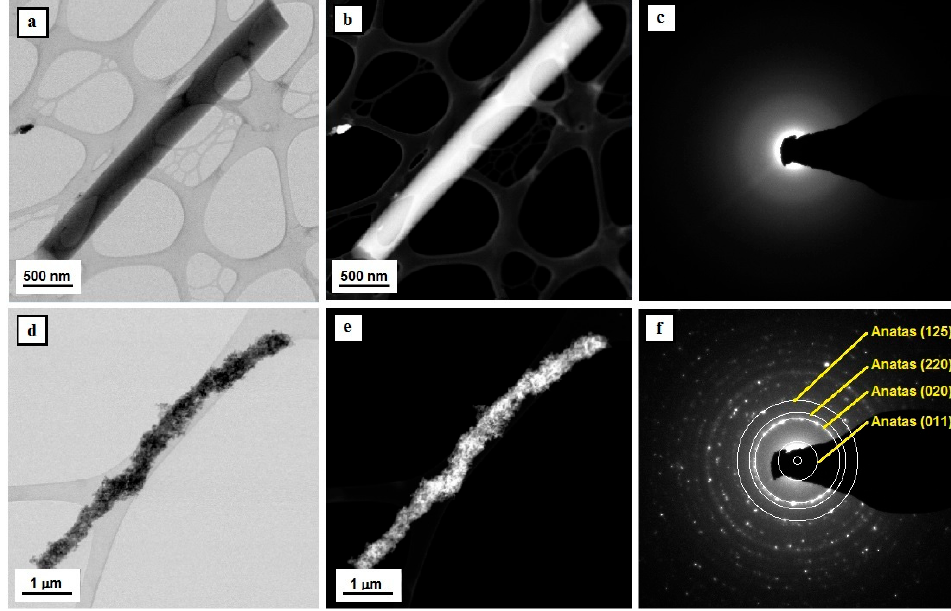
Figure 4. TEM images of the tested nanostructures—Tio 2 nanowires comprising a matrix for TiO 2 /TiO 2 NPs bimodal nanowires ( a , b , d , e ) along with diffraction images obtained with the use of analytical microscopy in nano areas in STEM mode and solved electronograms for nanoparticles and nanowires of titanium oxide ( c , f ).